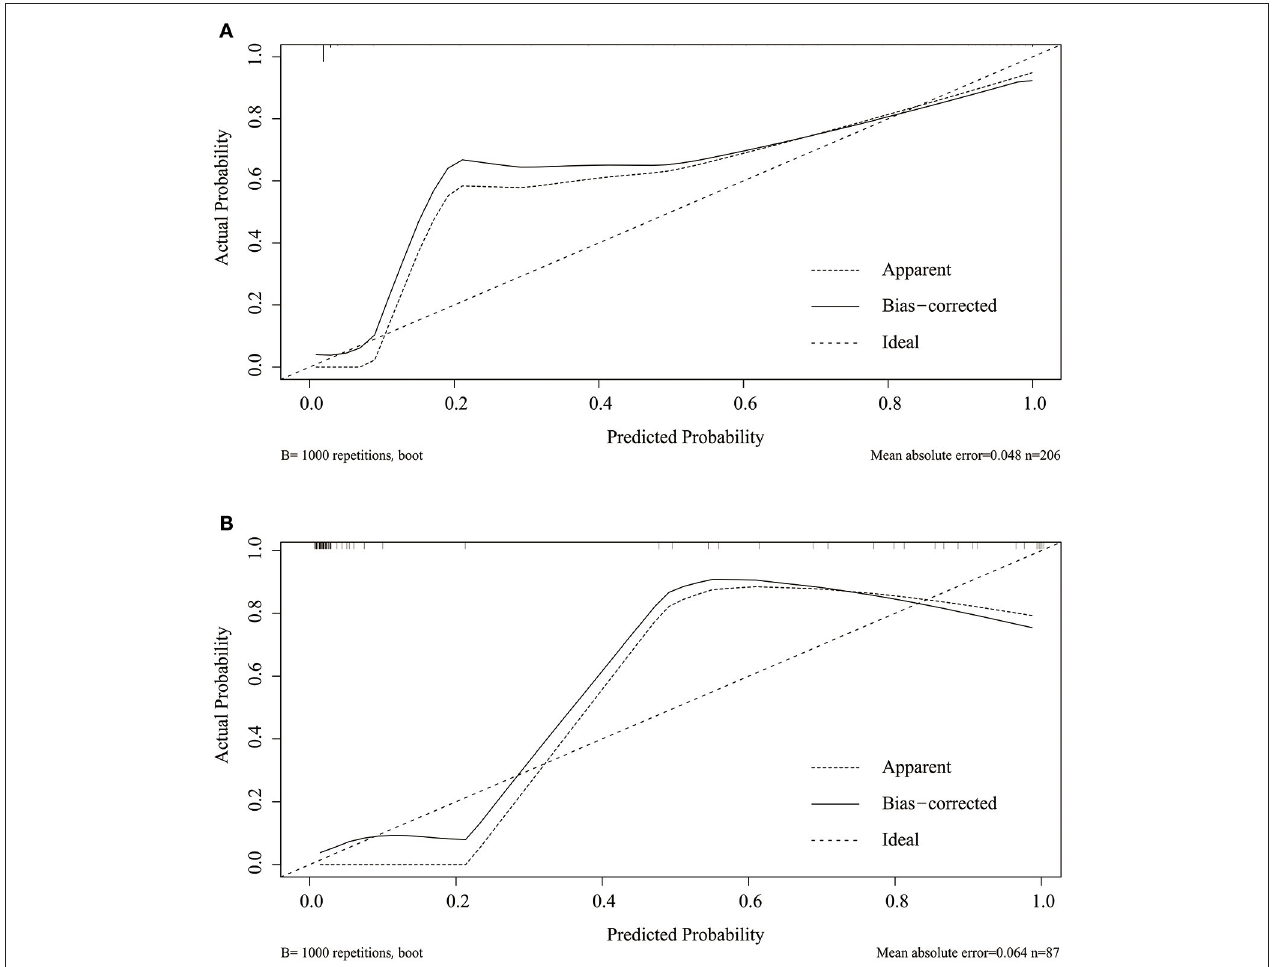
FIGURE 4 | Calibration plot of the nomogram in the training (A) and validation set (B) . Predictions generated from the model are plotted against actual patient outcomes. The 45-degree line represents the perfect model calibration. The dotted line (apparent) indicates calibration when the model is applied to each set, and the solid line (bias-corrected) indicates calibration when the model is applied to the bootstrap